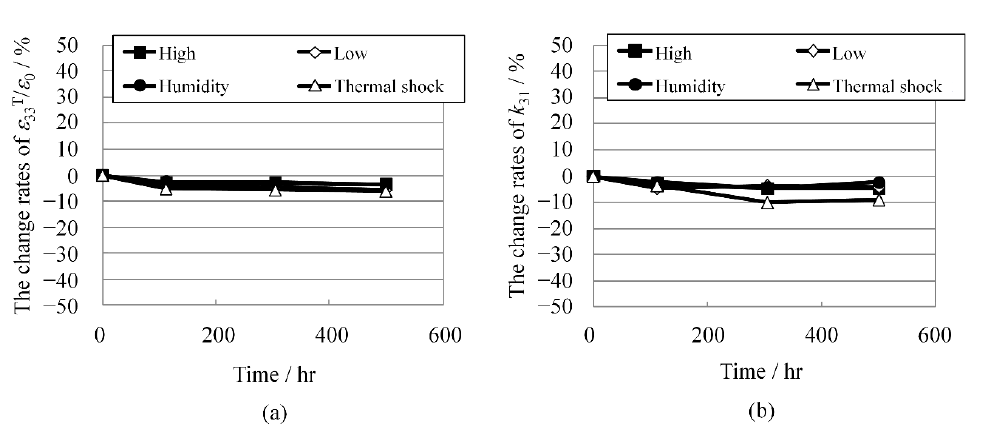
Figure 7. ( a ) Change rates of dielectric constant ε 33T / ε 0 ; and ( b ) change rates of electromechanical coupling coefficient k 31 under reliability test conditions.